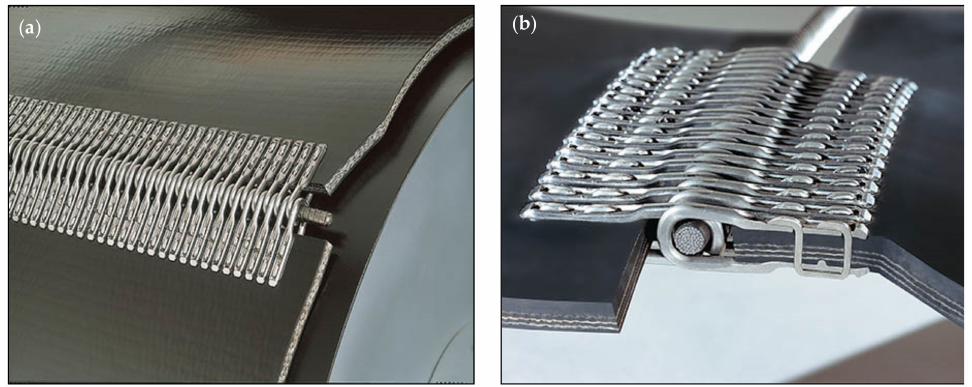
Figure 10. Staple fastening: ( a ) general view; ( b ) side view